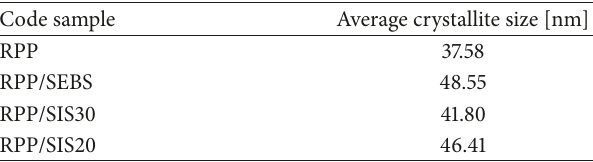
Table 6: Average crystallite sizes (nm) for RPP compounds and unmodified RPP.